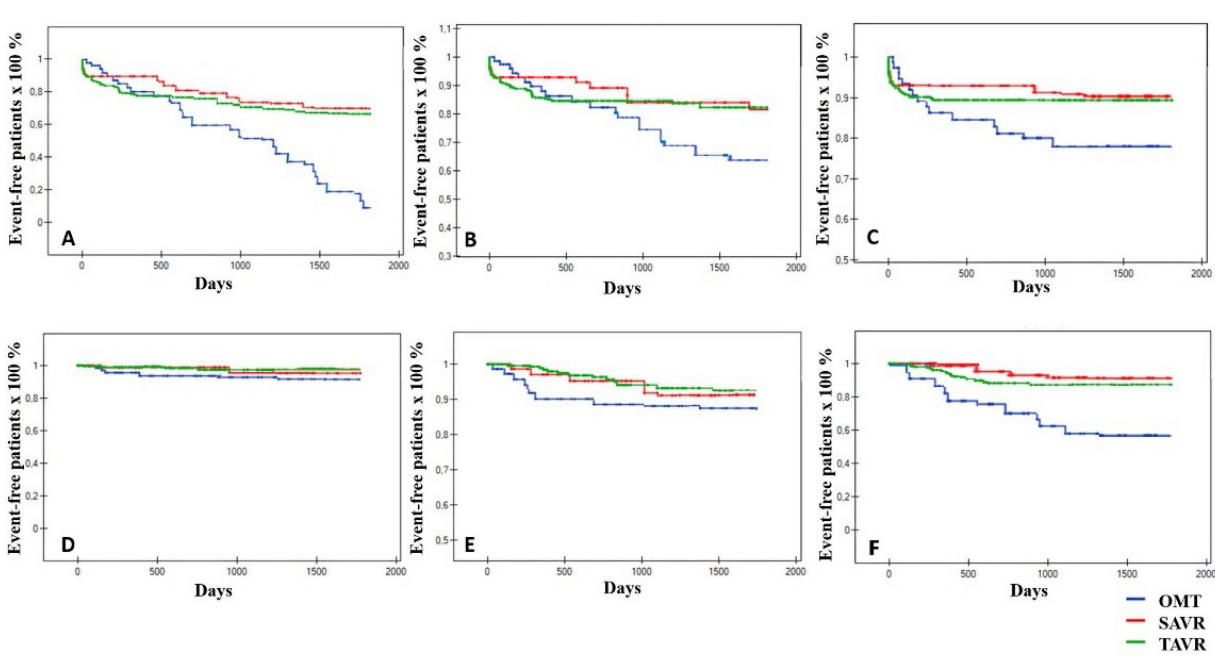
Figure 2. The Kaplan–Meier curves for endpoints. AS—aortic stenosis; TAVR—transcatheter aortic valve replacement; SAVR—surgical aortic valve replacement; OMT—optimal medical therapy; ( A )—primary endpoint; ( B )—all-cause mortality; ( C )—CV (cardiovascular) death; ( D )—non-fatal MI (myocardial infarction); ( E )—non-fatal strokes; ( F )—non-fatal rehospitalizations due to AS.